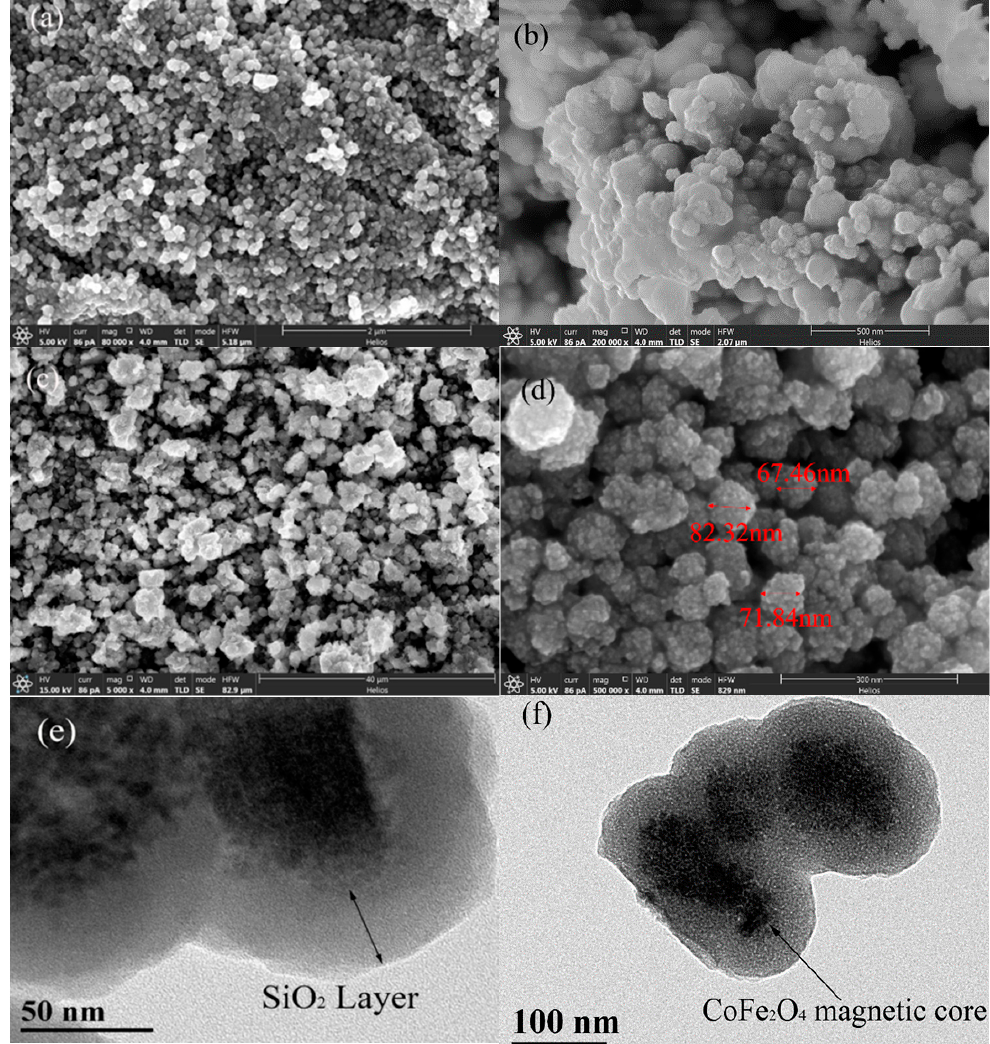
Figure 2. ( a ) SEM images of CoFe 2 O 4 magnetic nanomaterials (MNPs), Magnification: 80,000×; ( b ) CoFe 2 O 4 @SiO 2 MNPs, Magnification: 200,000×; ( c ) CoFe 2 O 4 @SiO 2 –NH 2 MNPs, Magnification: 5000×;